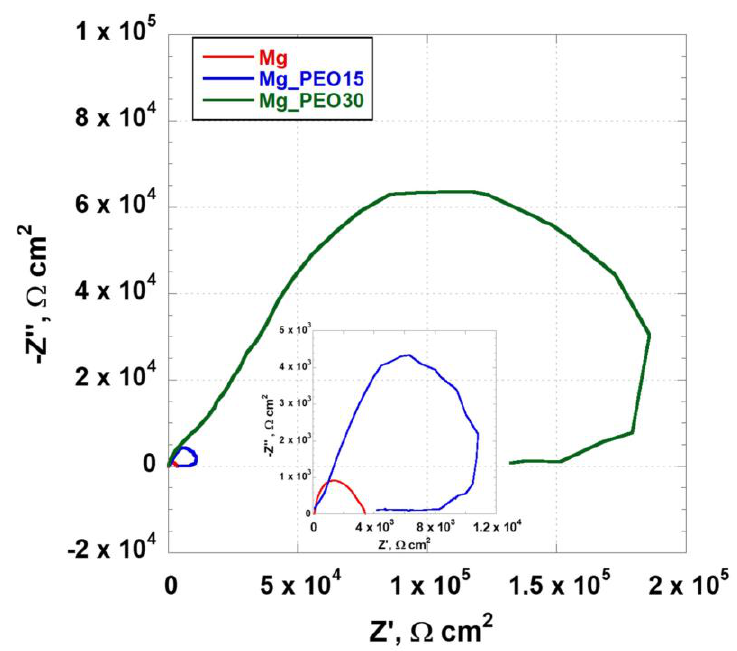
Figure 10. Nyquist plots of samples characterized in Hank’s solution at 37 °C.